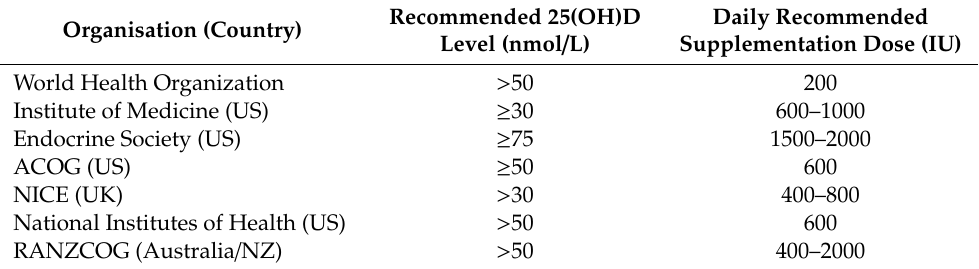
Table 2. Recommendations for total 25(OH)D concentrations and daily supplementation doses during pregnancy by international health organisations, 2016 (derived from Mousa, et al.